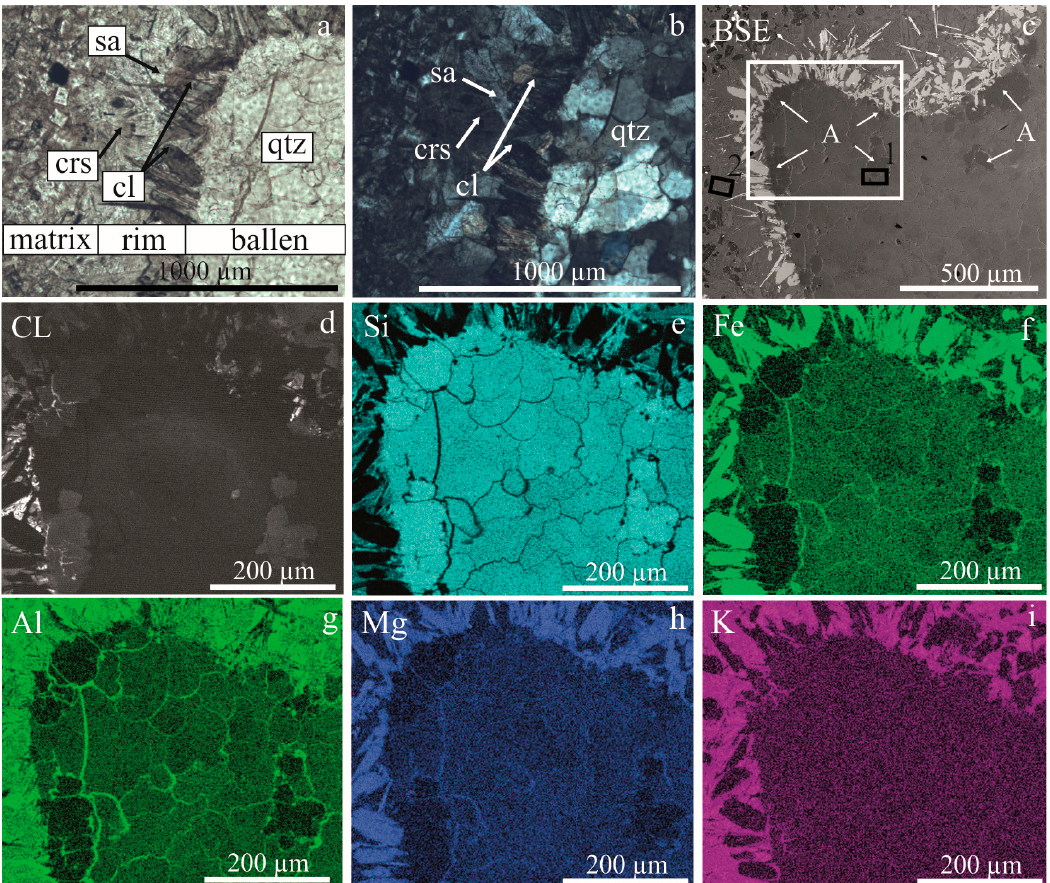
Figure 2. Images of the Jänisjärvi impact melt rock of ballen quartz: microphotographs under plane-polarized light ( a ) and cross-polarized light ( b ); BSE image (white square shows an area where EDS element distribution mapping was performed, black rectangle (1,2) mark areas where Raman mapping (Figure 6) was performed), A—domains of type A ( c ); CL image ( d ); EDS element distribution maps (Si K α , Fe K α , Al K α , Mg K α , and K K α X-ray lines) ( e – i ). Crs, cristobalite; cl, chlorite; qtz, quartz; sa, sanidine.